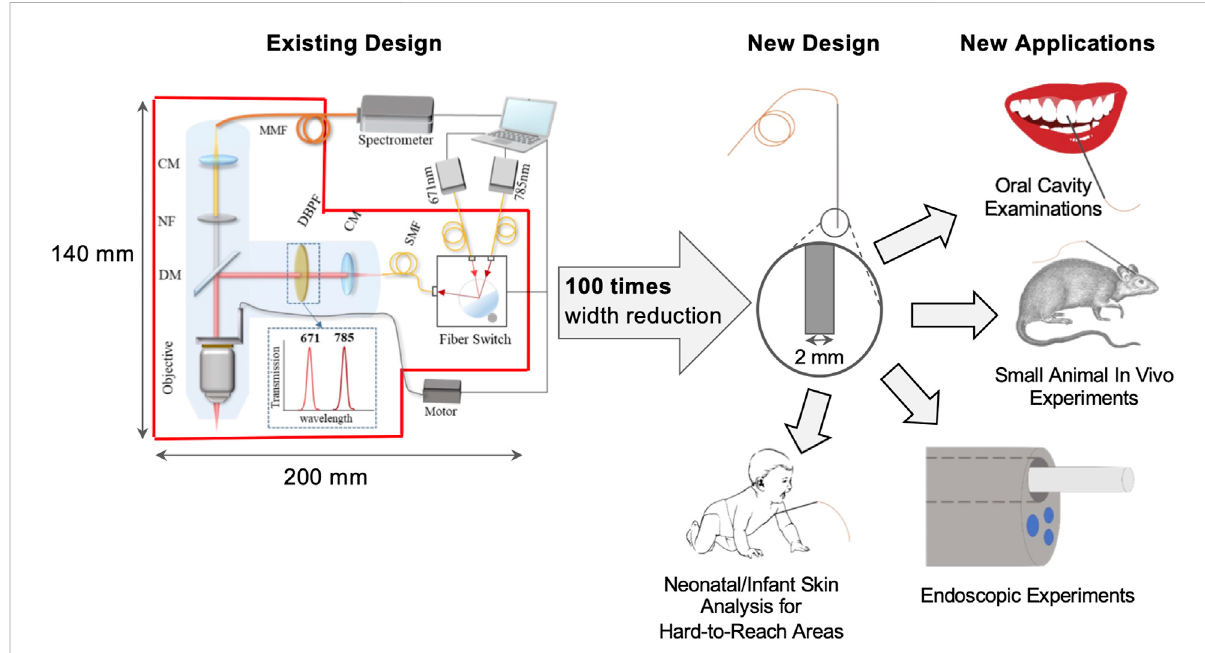
FIGURE 1 Overview of existing and new design of Raman probe. Schematics of existing and new probes and potential applications of the new